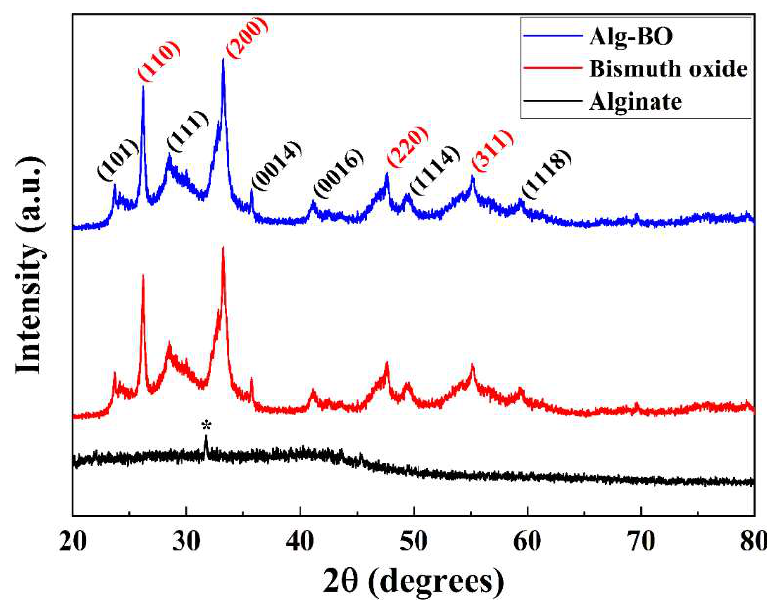
Figure 2. Powder X-ray diffraction patterns of Alg, BO, and Alg–BO (asterisk indicates (111) diffraction from Alg; black and red Miller indices indicate two bismuth oxide forms: Bi 2 O 2.33 and γ-Bi 2 O 3 , respectively).